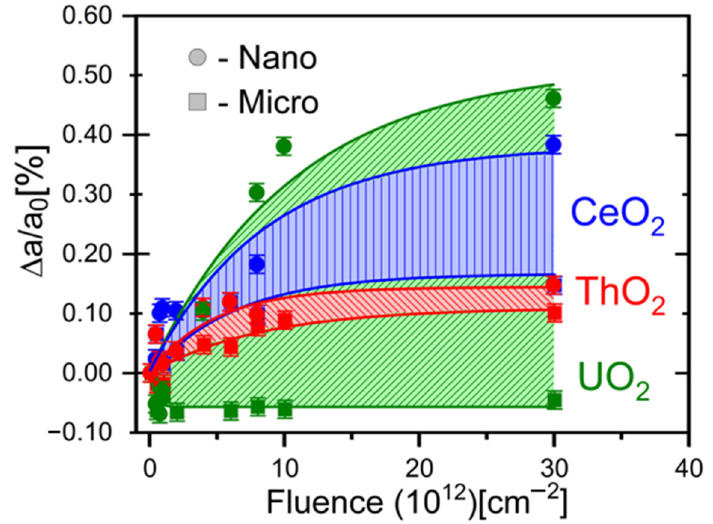
Figure 9. Relative change in unit cell parameter from XRD measurements as a function of fluence for microcrystalline (squares) and nanocrystalline (circles) UO 2 (green), ThO 2 (red), and CeO 2 (blue) irradiated with 946 MeV 197 Au ions. The shading displays the variation in irradiation-induced unit cell parameter changes between microcrystalline (2 μ m) and nanocrystalline (20 nm) samples for each material. Adapted from Cureton et al. [53].